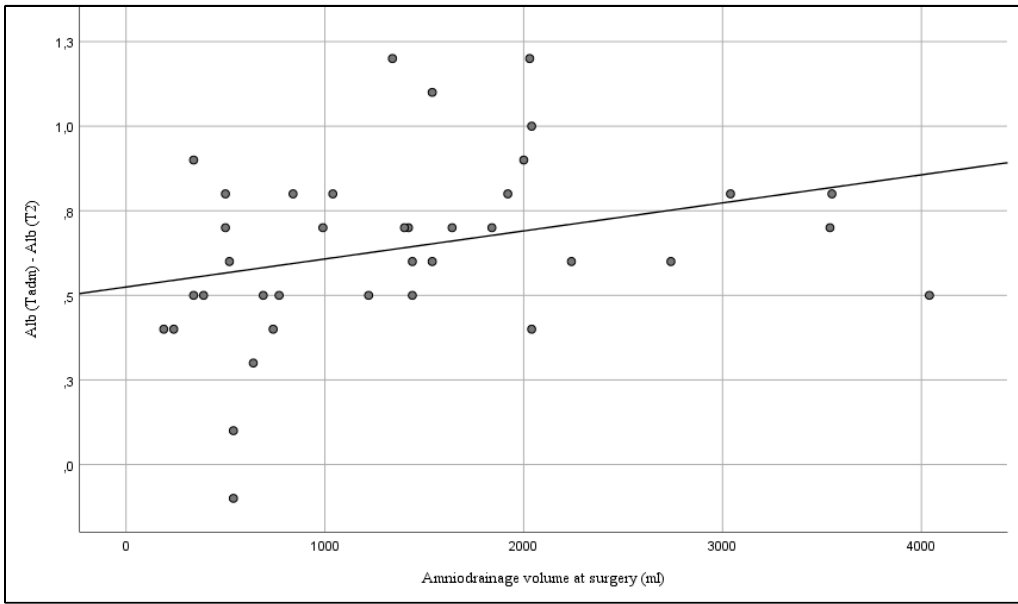
Figure 5. Correlation between the volume of amniodrainage at surgery and changes of maternal serum albumin (Alb) within 24 h after the intervention (Spearman’s rho 0.360; p = 0.027).